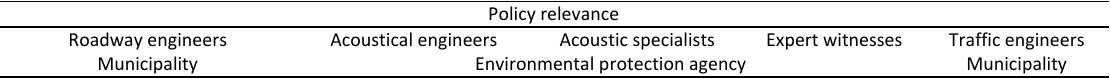
Table 1. Noise model stakeholders categorized based on policy relevance.